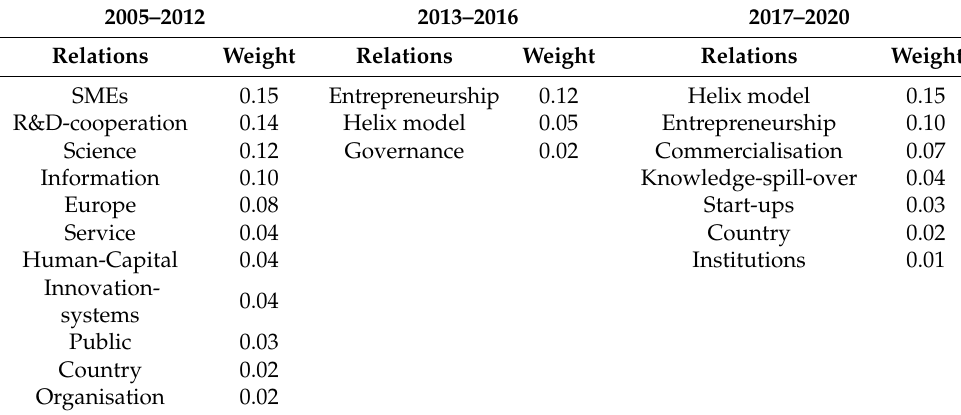
Table 8. Thematic network